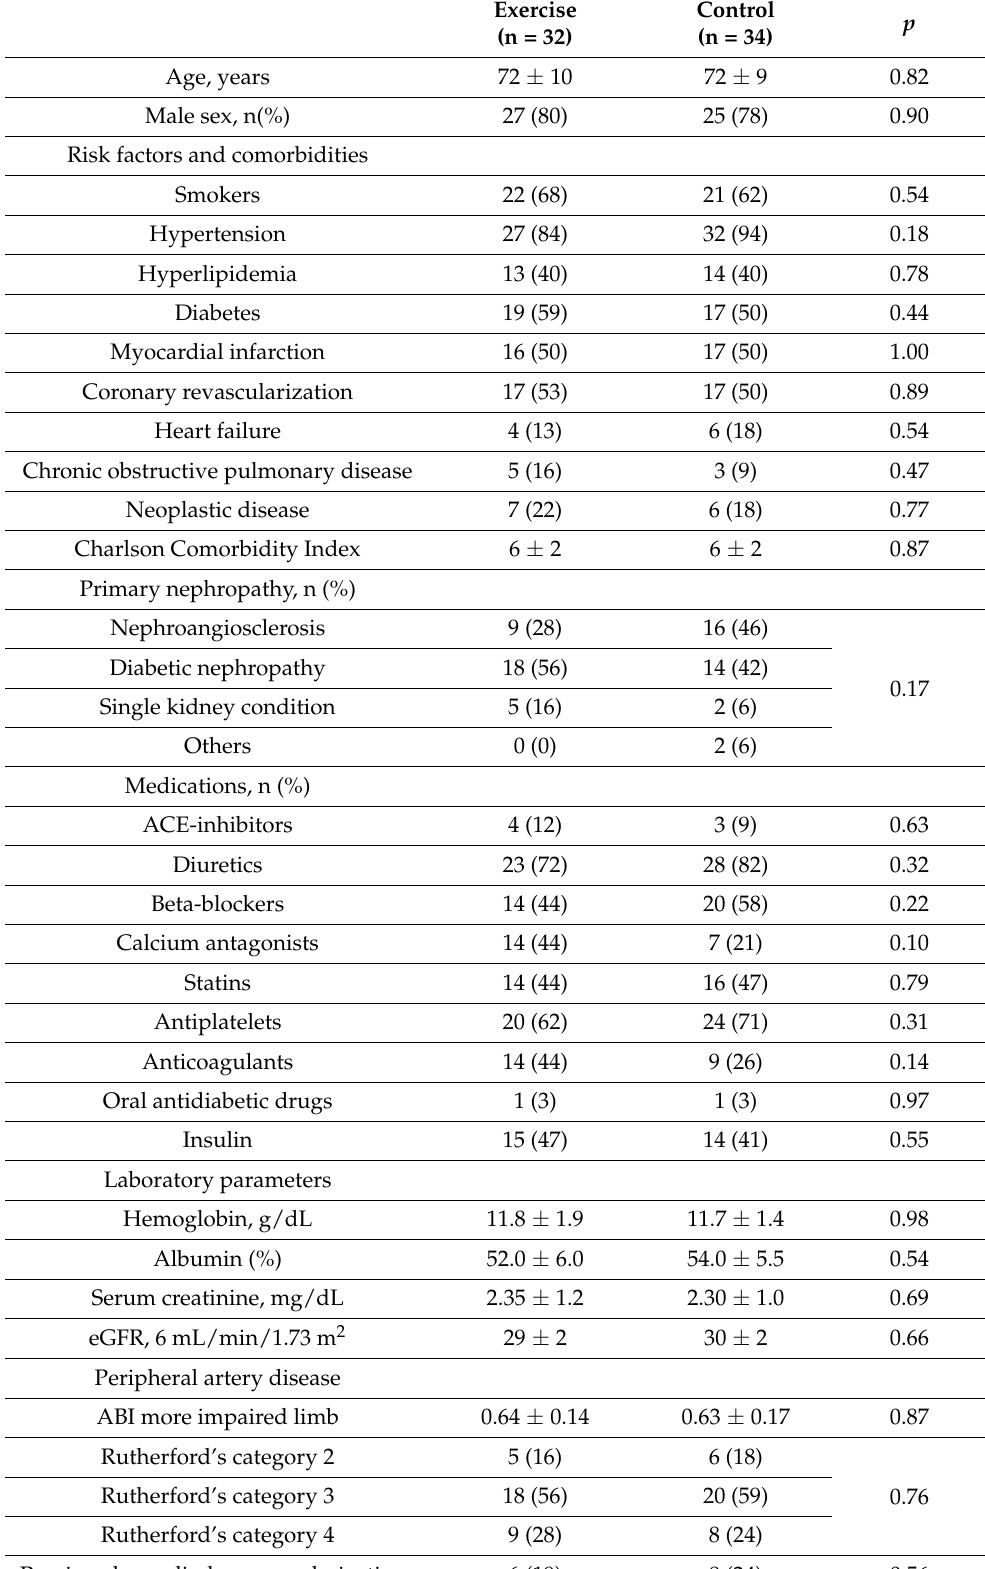
Table 1. Baseline comparison of the two groups under